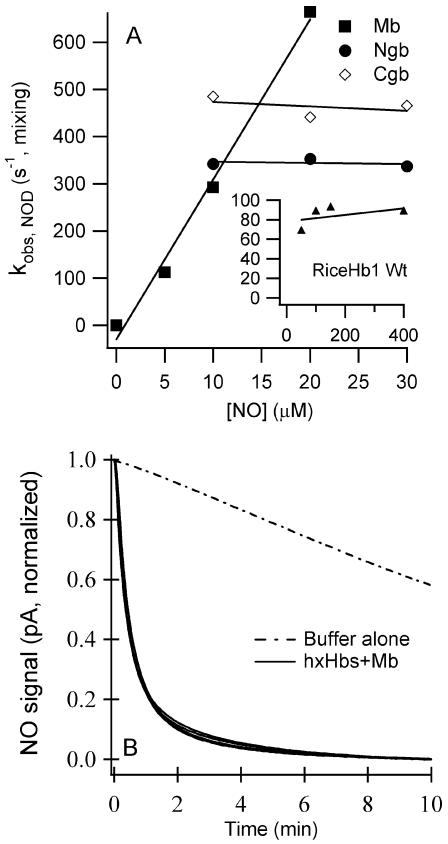
NO dioxygenation and stoichiometric NO consumption.Plots of kobs,NOD vs [NO] for the NOD reaction following rapid mixing.